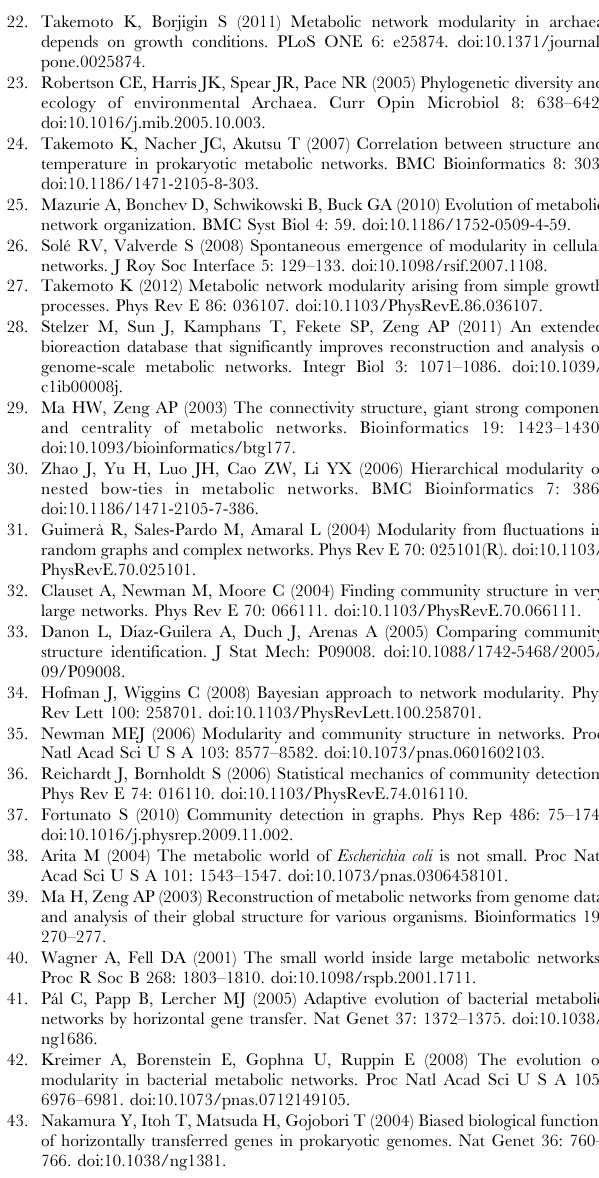
Table S1 List of bacterial species. This table includes the species name, Kyoto Encyclopedia of Genes and Genomes (KEGG) ID (see http://www.genome.jp/kegg/catalog/org_list. html), genome size, number of protein-encoding genes, habitat variability, oxygen requirements, growth temperature, and extent of horizontal gene transfer for each bacterium. In addition, it includes the following parameters from the latest and earlier versions of each bacterial metabolic network (compound network): modularity value Q , normalized modularity value Q m , number of nodes (metabolites), number of edges (substrate–product pairs), and number of new edges among nodes that existed in the earlier version. In the case of the latest version of metabolic networks, the modularity value Q SA in the largest connected